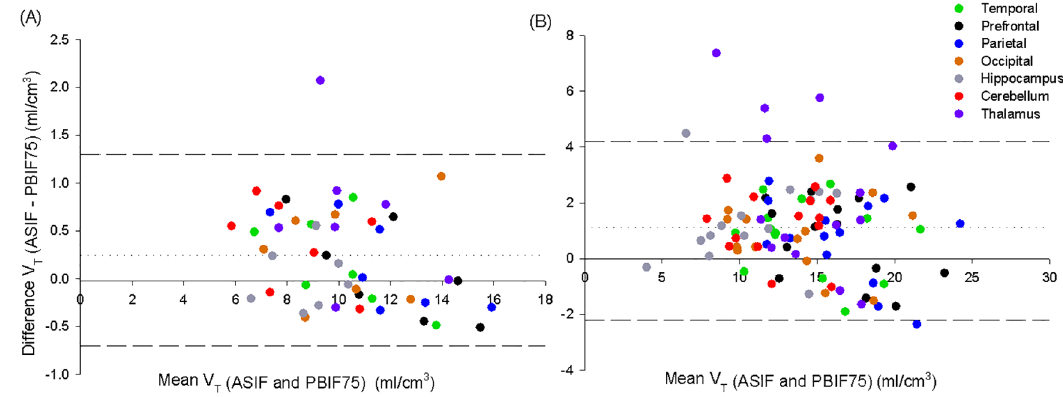
Fig 3. Bland-altman plot of V T assessedby ASIF (2-TCM) and PBIF75 (Logan plot) for 7 regions of interest in healthy controls. FEPPA V T s derived by Logan PBIF75 plot slightly underestimated (Bias < 1 mL/cm 3 ) those derivedwith 2-TCM. (A) In MABs (n = 7), the 95% limits of agreement(dashed lines ) was between-0.7 to 1.3 mL/cm 3 and no systematic bias was observed(r = 0.12, p = 0.6). (B) In HABs (n = 14), the 95% limits of agreement (dashedlines) was between-2.2 to 4.2 mL/cm 3 and no systematic bias was observed(r = 0.08, p = 0.7).